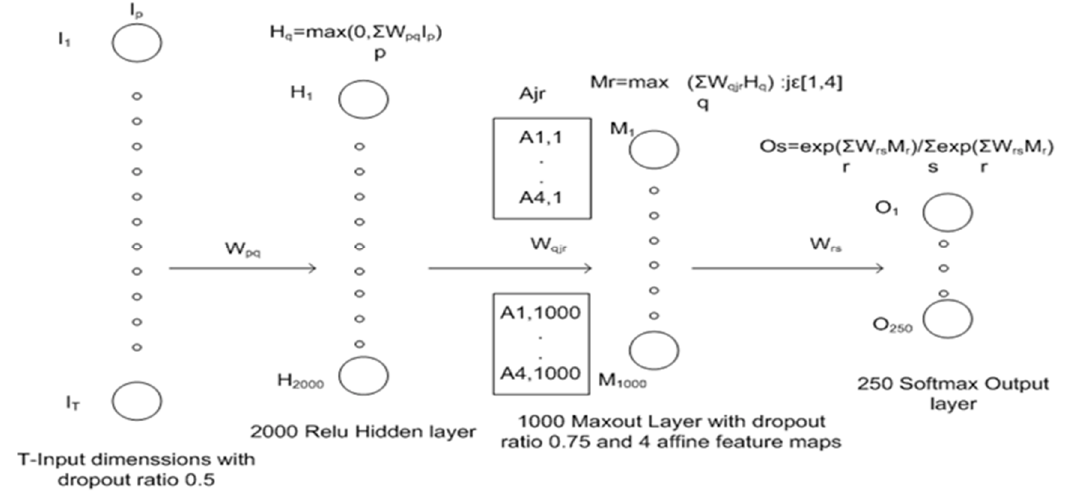
Figure 1. Neural network model.